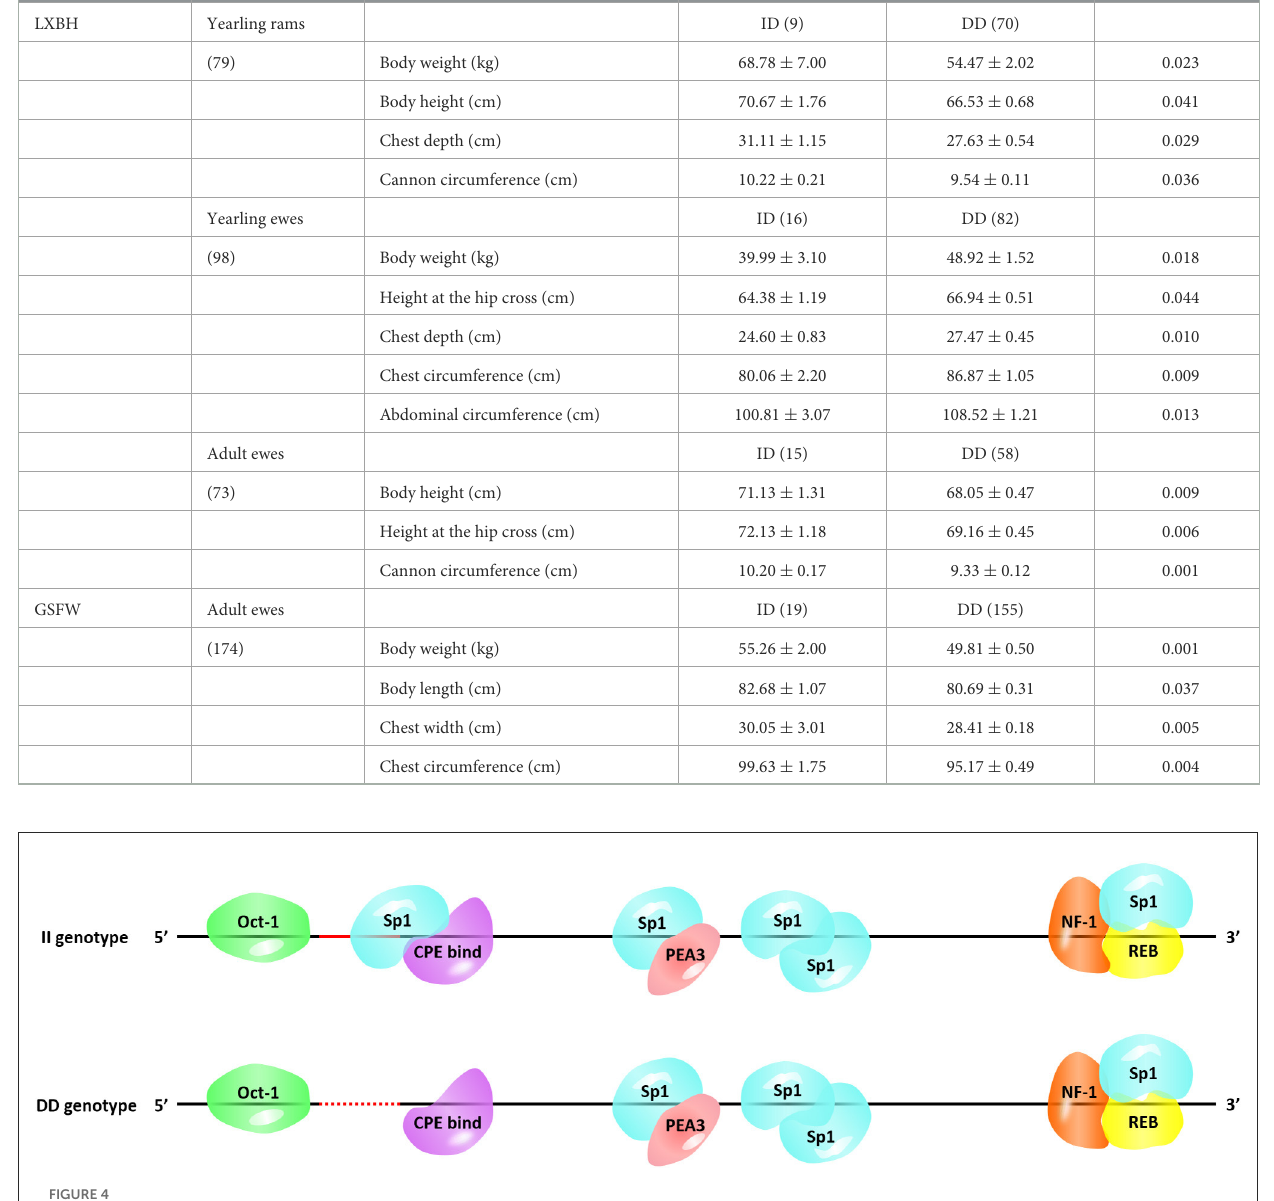
genotype had significantly higher body weight, chest depth, chest circumference, height at the hip cross and abdominal circumference than those with the heterozygous ID genotype ( P < 0.05). Additionally, adult ewes exhibited significant differences in height at the hip cross, body height, and cannon circumference ( P < 0.01), with the heterozygous ID genotype being the dominant individual. For GSFW sheep, adult ewes with the heterozygous ID genotype showed superior performance compared to those with the homozygous DD genotype with regards to body weight, body length, chest width, and chest